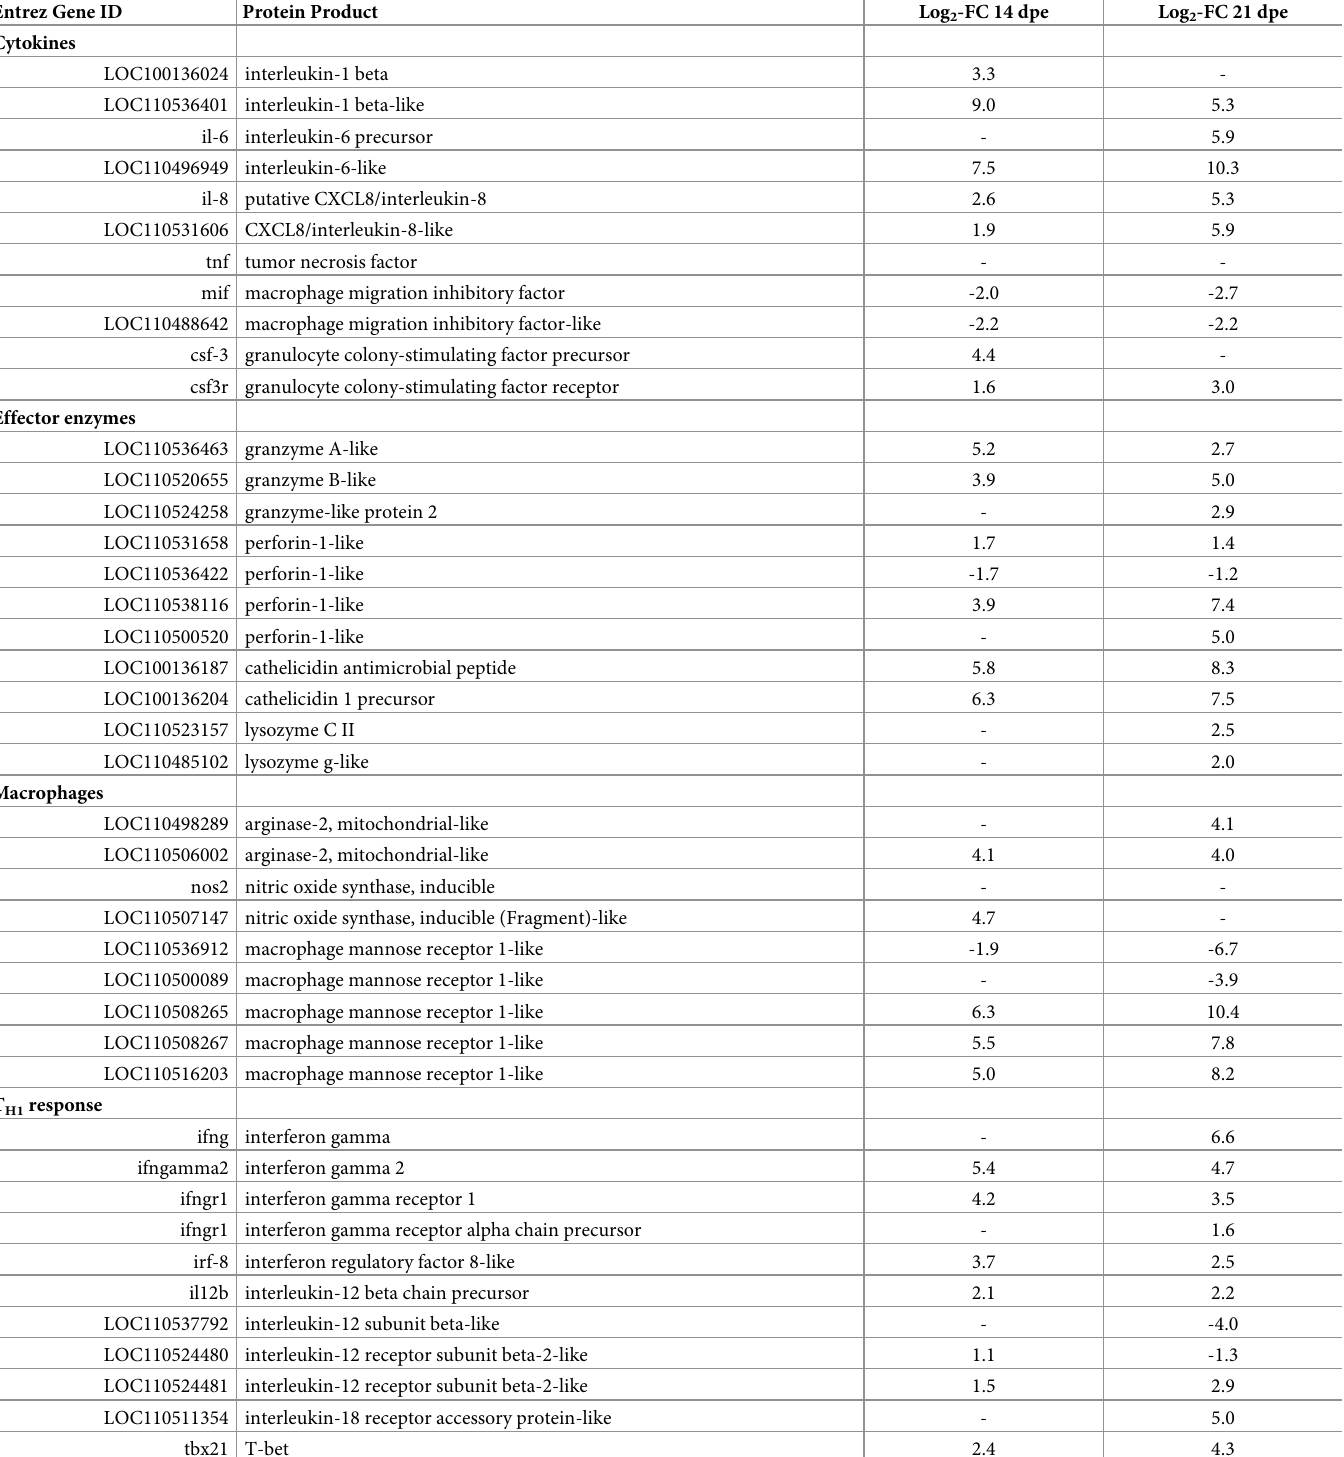
Table 5. Select immune genes that were differentially expressed in the intestine of susceptible steelhead at 14- and 21-days post exposure (dpe) to Ceratonova shasta